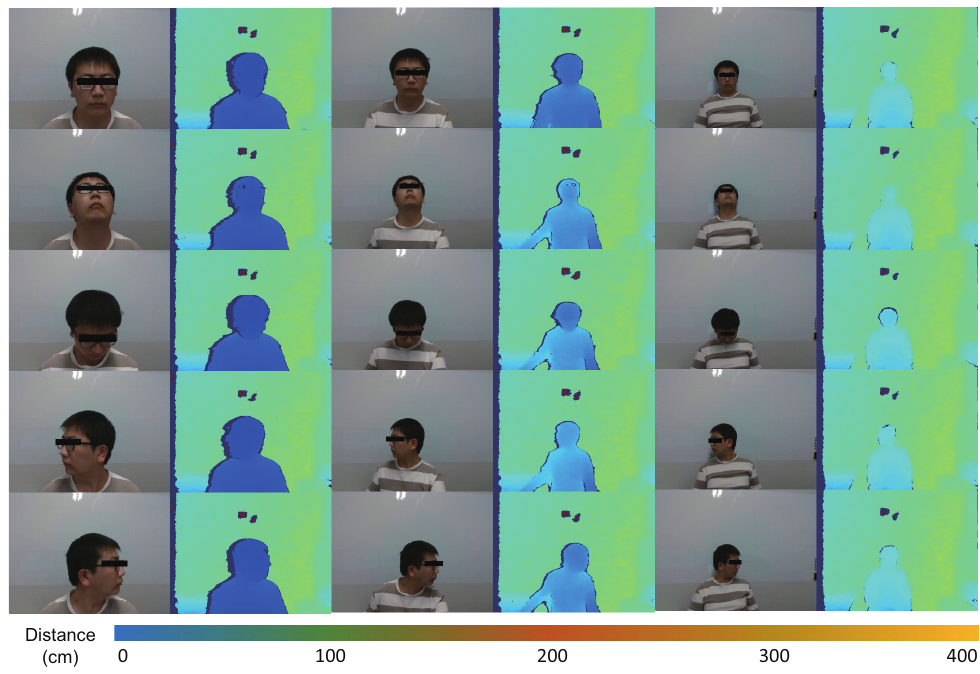
Figure 10. Representative eye line mosaic effects using bone sensing and depth camera.